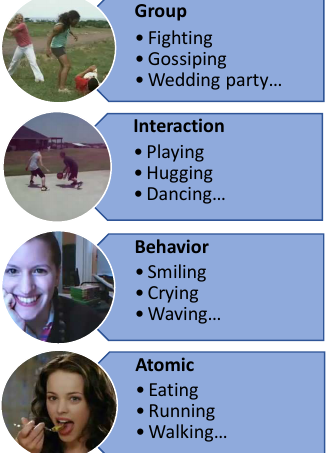
Figure 15. Activity type hierarchy. Images are from HOLLYWOOD 2 [216], UCF50 [217], MCAD [218], and NTU RGB+D [142]